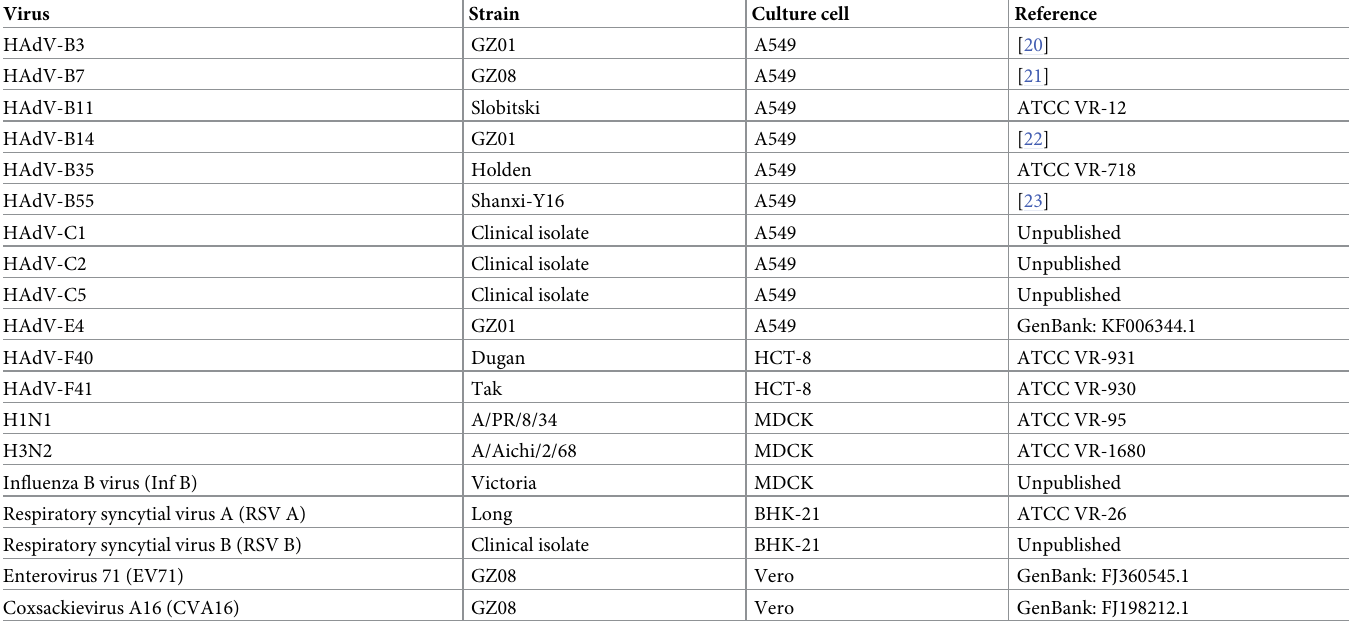
Table 1. The viruses used in this study.